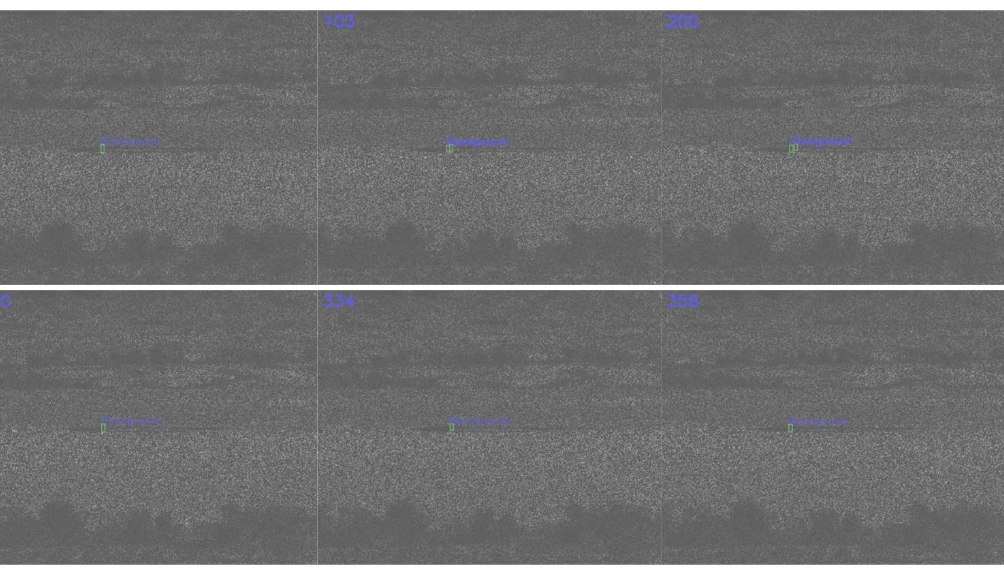
Figure 8. Detection results for MWIR PCE in PCE/CA 25% mode (75%